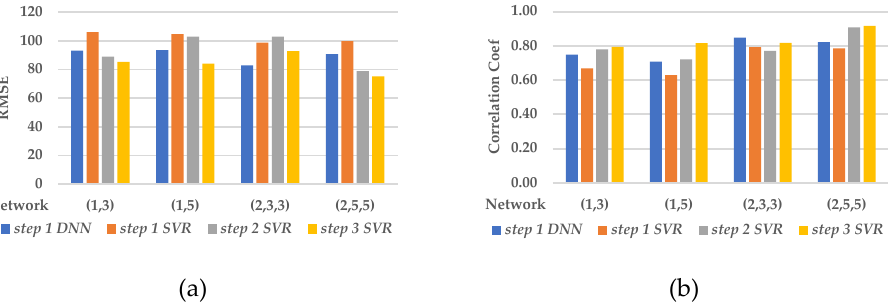
Figure 7. Performance for each architecture with stepwise improvement. ( a ) RMSE and ( b ) Pearson correlation coefficient.